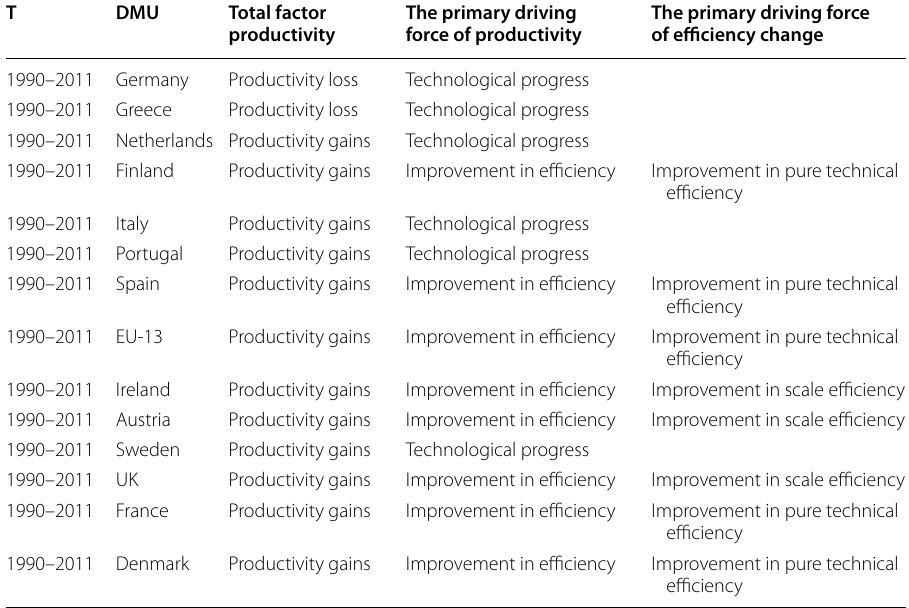
Table 2 The driving forces of total factor productivity index of economic systems by coun- try T